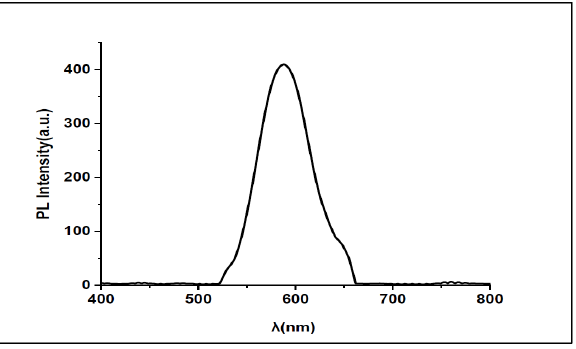
Figure 5: Photoluminescence spectra (PL) of a PSs layer created with etching current densities of J= 12 mA/cm 2 , etching duration of 10 minutes, and HFc 40%.